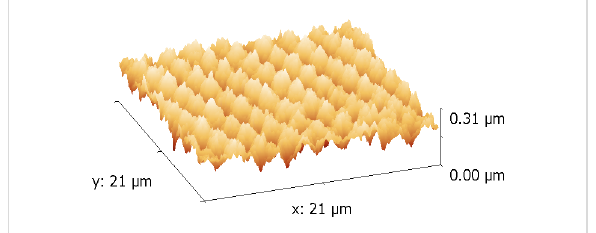
Figure 8: AFM picture of the surface structure of the 52Au nanocom-